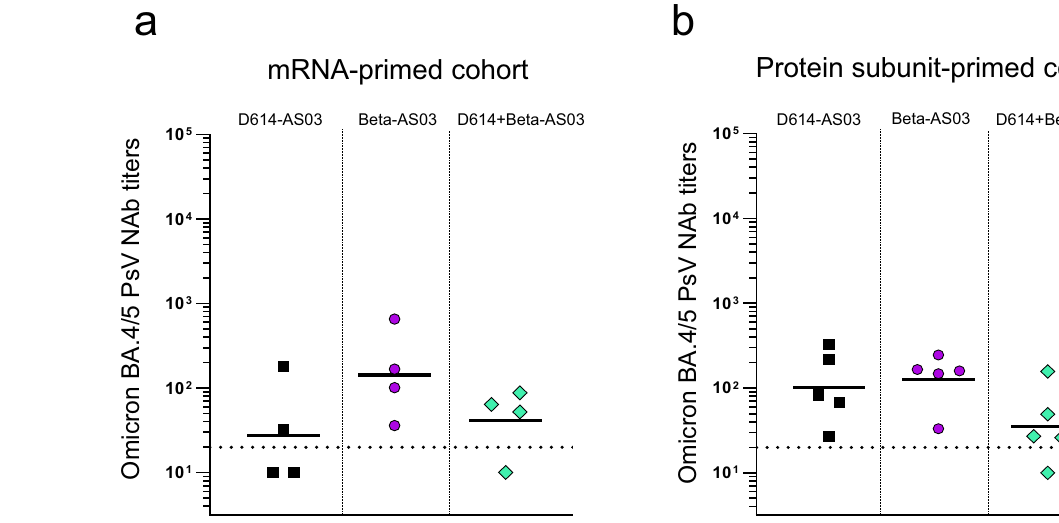
D614 vaccine, Beta vaccine or bivalent ancestral + Beta vaccine in macaques pre- viously immunized with a mRNA vaccine candidate ( n =4) or b protein-subunit vaccine candidate ( n =5).